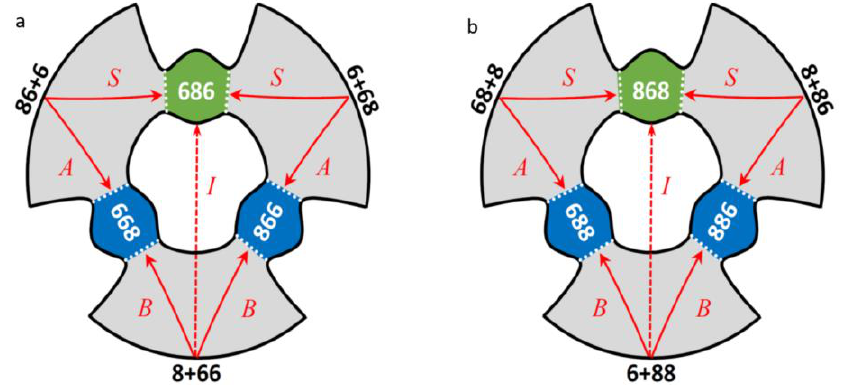
Figure 1. Schematic of the global PES of ozone that possesses a three-fold symmetry with respect to the entrance channels and the product wells, but this symmetry is lowered when rare isotopes are introduced. The channels and the wells are labeled for singly substituted ( a ) and doubly substituted ( b ) isotopologues, respectively. Reagents are indicated by black numbers, the product ozone molecules by white numbers, dotted lines are drawn through transition state regions seen as “bottlenecks” in this figure. Four distinguishable reaction pathways are also indicated in each case, by red letters and arrows. The insertion pathway is shown schematically by dashed arrow.